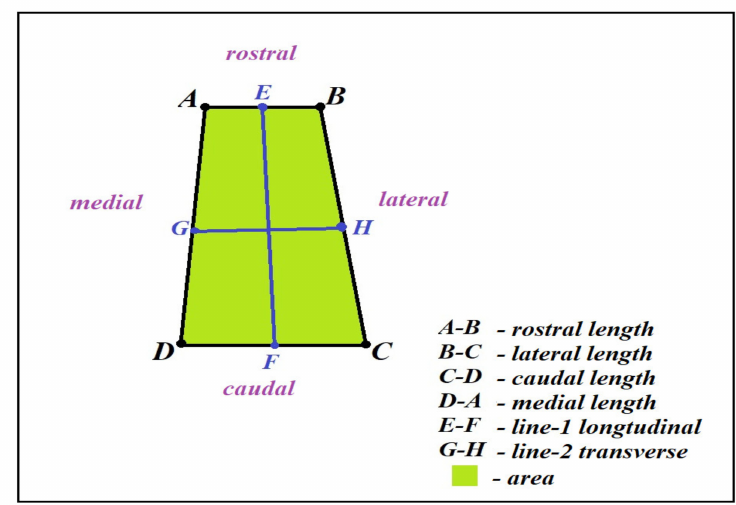
Figure 2. The schematic illustration of the seven measurements (rostral (from point A to point B ); lateral (from point B to point C ); caudal (from point C to point D ); medial (from point D to point A ); line-1 longitudinal (from point E to point F ); line-2 transverse (from point G to point H ); area (green color)) situated on one side of the 3D printed model (CT). The orientation of each measurement was appointed (rostral, caudal, medial, lateral). Point E = 1 / 2 AB rostral length; point F = 1 / 2 CD caudal length; point G = 1 / 2 DA medial length; point H = 1 / 2 BC lateral length.